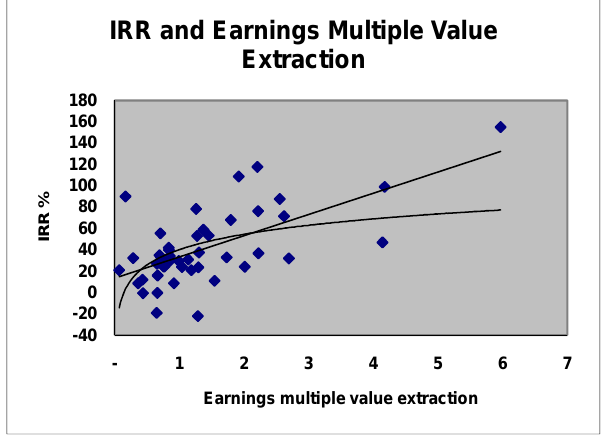
Figure 7: IRR and total investment cost scatter plot